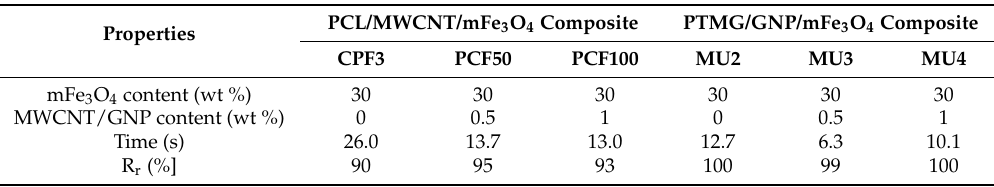
Table 11. Memory shape properties at temperature 45 ◦ C in water bath of materials obtained by Cai et al. [11,31] and materials obtained in this work according to the cycle